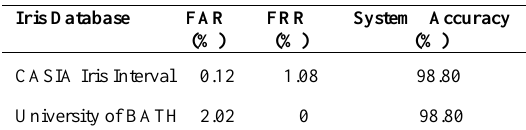
Table 5. FRR and FAR for two different databases with threshold of 0.4. Iris